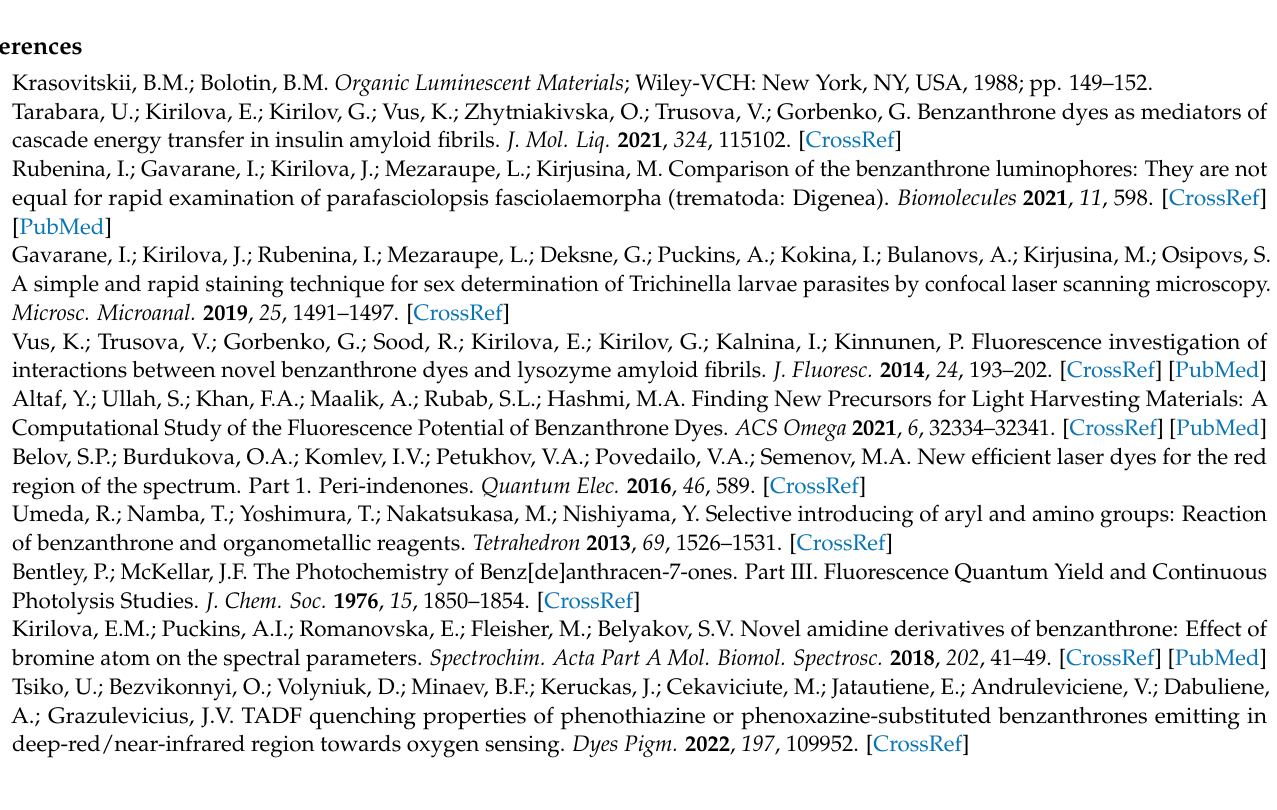
Supplementary Materials: The following are available online. Figure S1: 1 H-NMR spectrum of compound 2 ; Figure S2: 13 C NMR spectrum of compound 2 ; Figure S3: IR spectrum of compound 2